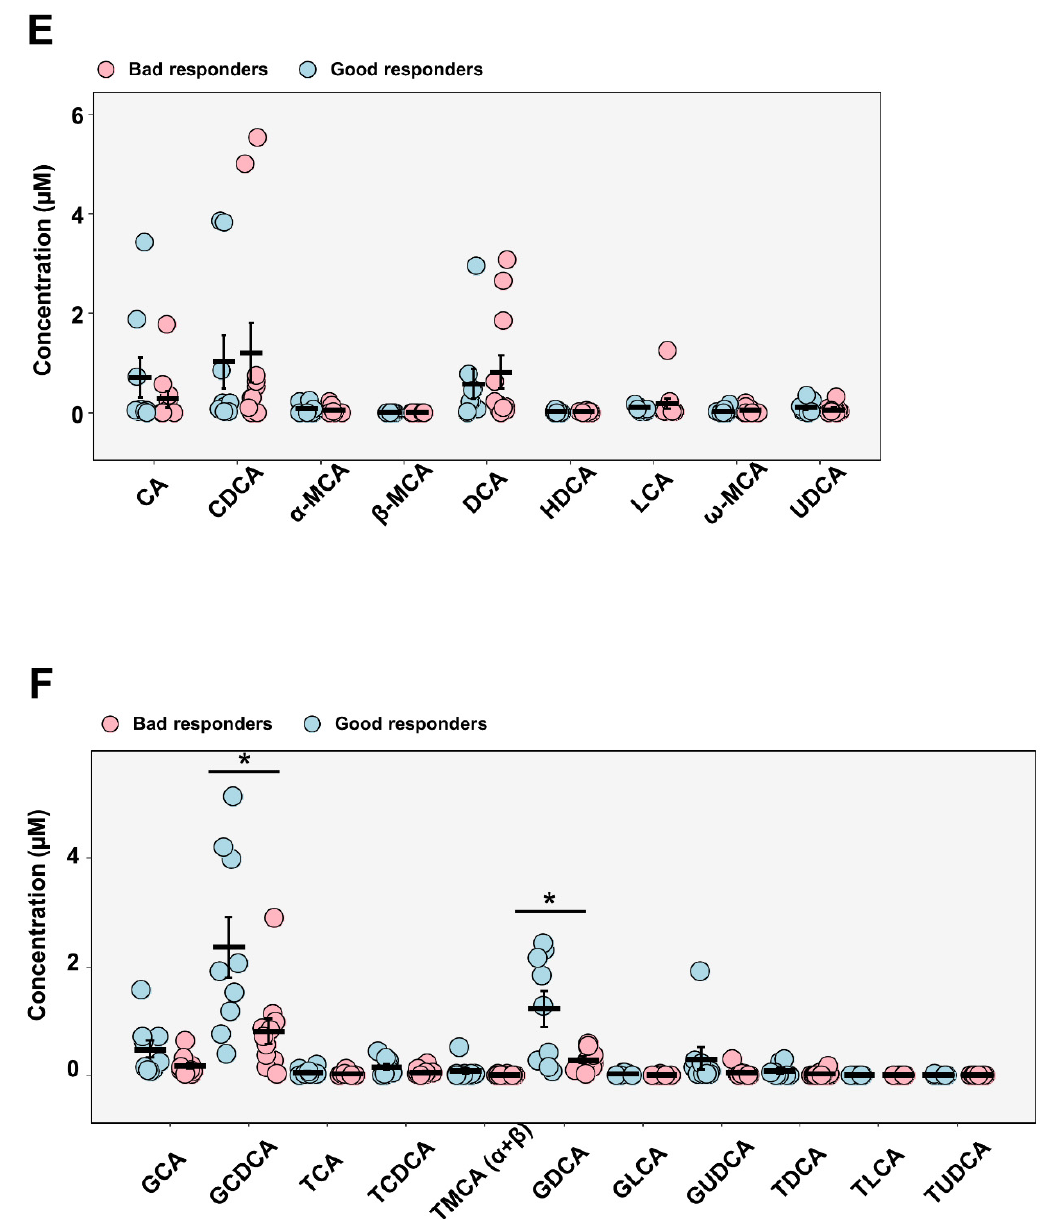
Figure 4. Serum bile acid concentrations in extreme weight loss responders to RYGB surgery. Principal component analyses of serum bile acid levels in good and bad responders ( A , B ) after RYGB surgery. Significance calculated by PERMANOVA ( C ) shows total unconjugated and conjugated fasting bile acid concentrations in good and bad responder groups which were further divided into primary and secondary bile acid species ( D ). Individual fasting bile acid concentrations shown in ( E , F ). Data shown as mean ± SEM. Group comparisons were performed with Student’s t ‐ test. The symbol * indicates a p ‐ value ≤ 0.05. CBA, conjugated bile acids; CpBA, conjugated primary bile acids; CsBA, conjugated secondary bile acids; UBA, unconjugated bile acids; UpBA, unconjugated primary bile acids; UsBA, unconjugated secondary bile acids; CA, cholic acid; CDCA, chenodeoxycholic acid; α‐ MCA, α‐ Muricholic acid; β‐ MCA, beta ‐ Muricholic acid; DCA, Deoxycholic acid; HDCA, Hyodeoxycholic acid; LCA, Lithocholic acid; ω‐ MCA, ω‐ Muricholic acid; UDCA, Ursodeoxycholic acid; GCA, glycocholic acid; GCDCA, glycochenodeoxycholic acid; TCA, Taurocholic acid; TCDCA, Taurochenodeoxycholic Acid; TMCA ( α + β ), Tauro ‐ muricholic acid; GLCA, glycolithocholic acid; GUDCA, Glycoursodeoxycholic acid; TDCA, Taurodeoxycholic acid; TLCA, Taurolithocholic acid; TUDCA, Tauroursodeoxycholic acid.